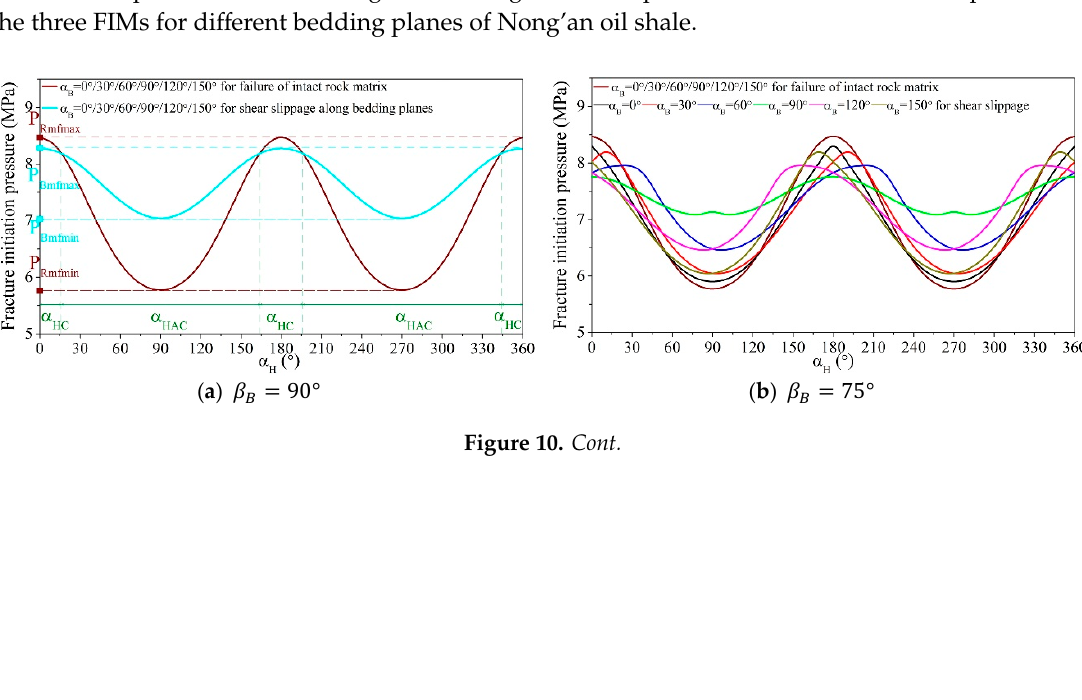
| ≠ = ±|𝜃 (cid:3021) (cid:3021)(cid:3040)(cid:3028)(cid:3051)